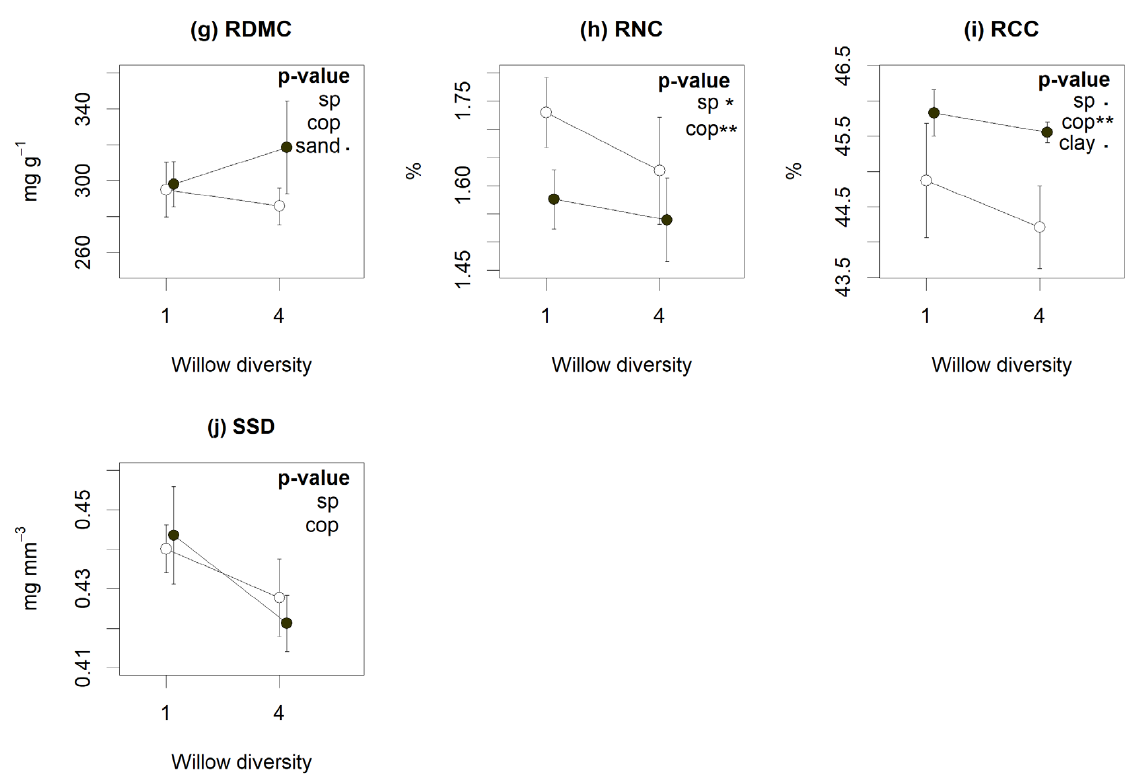
Figure 2. Influence of willow diversity (number of cultivars) (sp), coppicing (cop) and environmental factors (Organic matter (OM), clay (clay) and sand (sand) content and initial contamination content (t0)) on functional traits ( a – j ). Dots represent the traits means and bars the standard error of each cross-treatment. The coppiced (open symbols) and non-coppiced (closed symbols) treatments are aligned above the number of species (monoculture (1) or polyculture (4) plots). According to linear mixed models, treatments or factors with significant p -values are indicated by (.) for p < 0.10, (*) for p < 0.05 and (**) for p < 0.01. Abbreviations : leaf area (LA), specific leaf area (SLA), leaf pH (LpH), leaf and root dry matter content (LDMC and RDMC), leaf nitrogen and carbon content (LNC and LCC), root nitrogen and carbon content (RNC and RCC) and specific stem density (SSD).